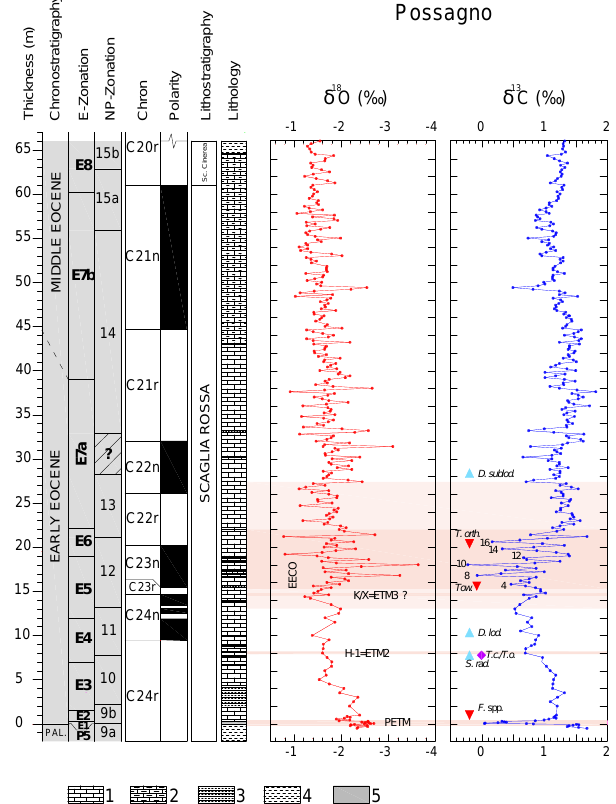
Figure 4. Lithology, stratigraphy and bulk sediment stable-isotope composition of the Possagno section aligned according to depth.